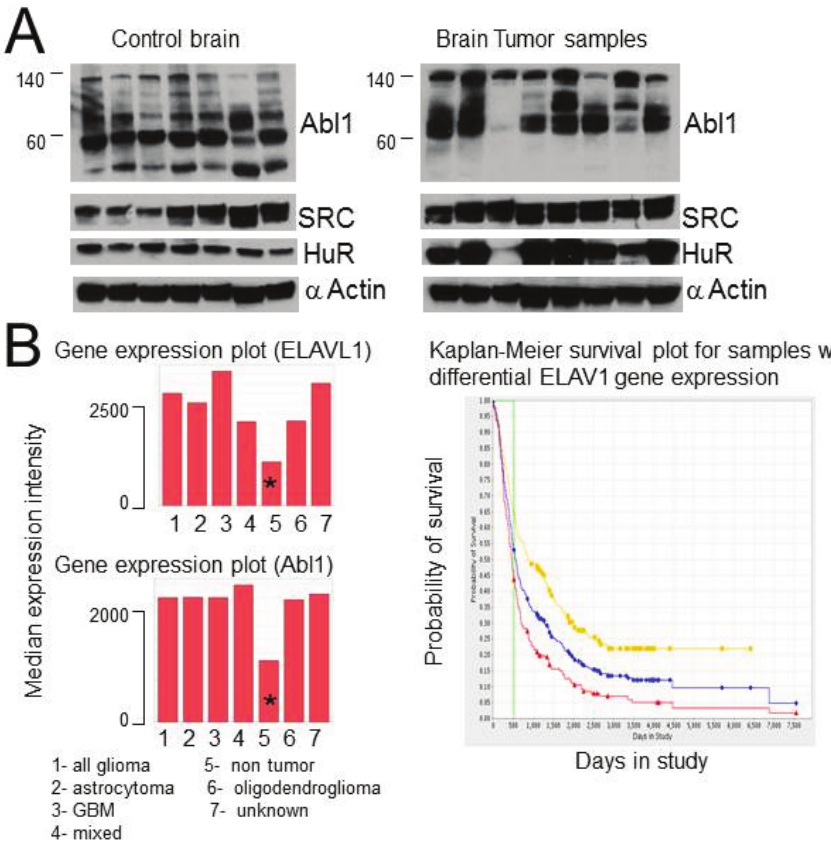
Figure 8. The expression of HuR, SRC, and Abl-1 in brain tumor and control samples. ( A ) Illustration of expression of HuR, SRC, and Abl-1 proteins in samples from brain tumor and control brain tissue. ( B ) Left—Profiles of HuR and Abl-1 mRNAs expression in different groups of brain tumors compared to non-tumor group. The data was obtained from Rembrandt National Cancer Institute database. * represents non-tumor control brain. Right—Illustrates Kaplan-Meier survival plot for GBM patients with different levels of ELAVL1 gene expression (201727—Taqman probe for ELAVL1 gene detection). The survival curves represent the following groups: red—up regulated (192), yellow—intermediate (150), green—down regulated (1), blue—all (343). Log-rank p-value for significance of different survival between up-regulated versus intermediate groups is 1.929E-7 (Rembrandt National Cancer Institute data